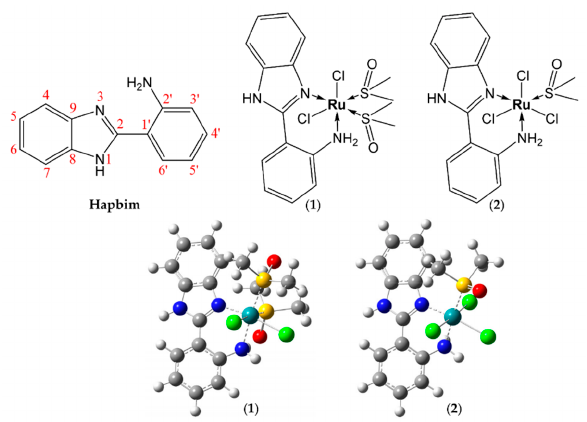
Figure 1. Chemical structures of 2-aminophenyl benzimidazole ligand ( Hapbim ), [Ru(II)Cl 2 (DMSO) 2 (Hapbim)] ( 1 ) and [Ru(III)Cl 3 (DMSO)(Hapbim)] ( 2 ), and DFT calculated structures of metal complexes.